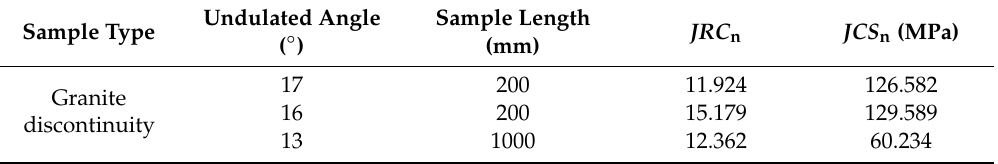
Table 3. Values of JRC n and JCS n for di ff erent granite discontinuity